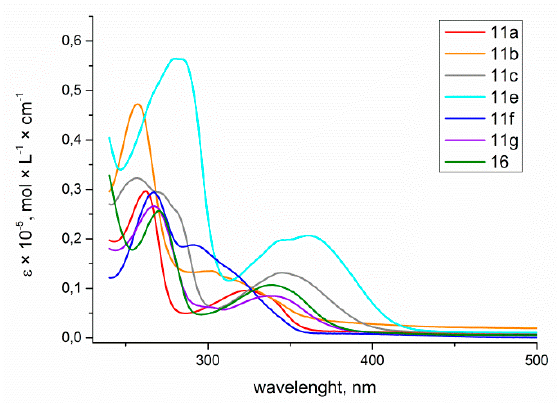
derivatives 11, 16 the absorption and emission spectra for the series of triazolylcinnolines 11a − c,e − g , 16 were measured (Figures 4, 5).